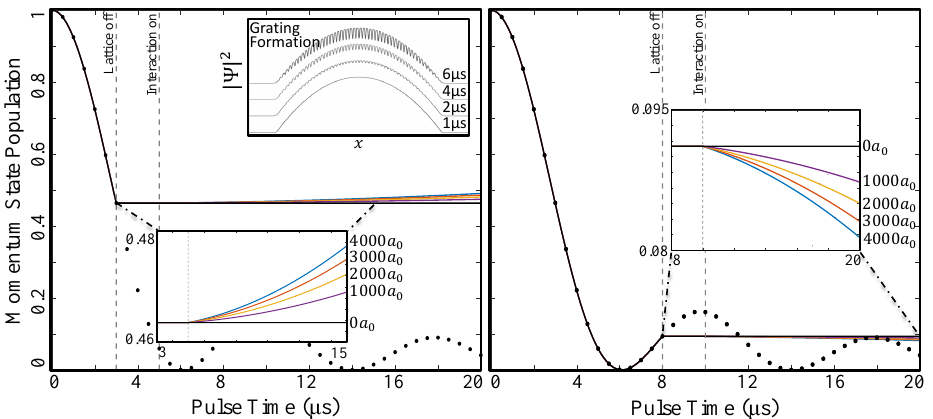
Figure 5: The simulated population evolution of 0 ħ hk momentum modes with quench- = 500 E ing interaction and U . Solid lines show the simulation results and dots r 0 plot the Bessel function prediction. The two vertical dashed line marks the time of = 3 µ s and t = 5 µ s, lattice switch-off and interaction switch-on, (left) t lat.off int.on = 8 µ s and t = 10 µ s respectively. The inset shows the formation (right) t lat.off int.on of density grating in the condensate